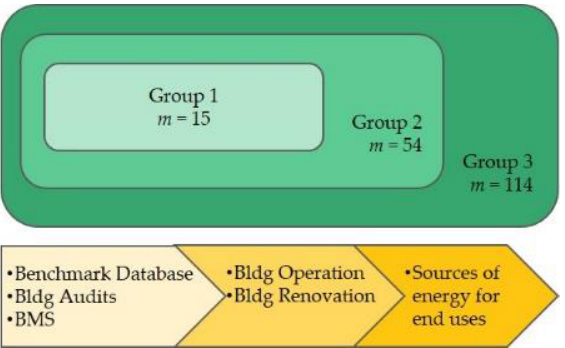
Figure 2. 5-Fold cross validation.